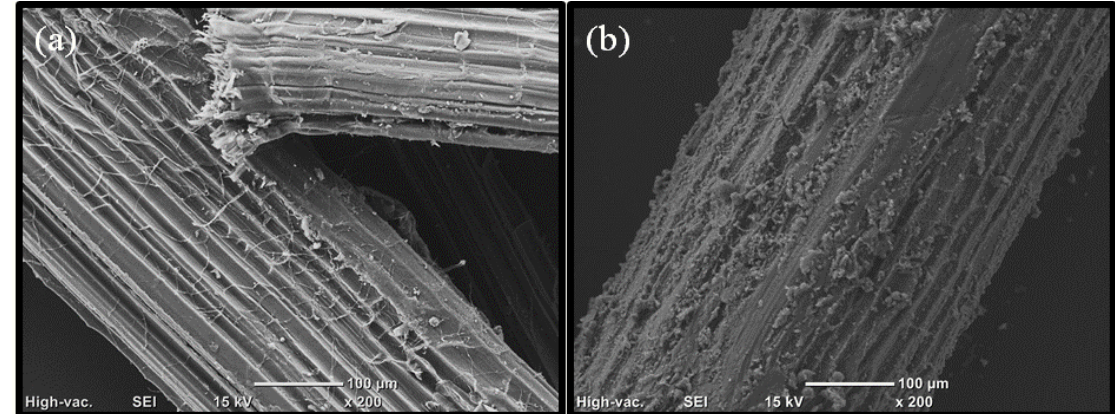
Thus, the thiol functionalization of WJF represents a convenient method to produce a co- Figure 4. SEM micrographs of: ( a ) untreated WJF and ( b ) thiol-functionalized WJF. valent bonding between the cellulose fibers and the polymeric Figure 4. SEM micrographs of: ( a ) untreated WJF and ( b ) thiol-functionalized WJF.